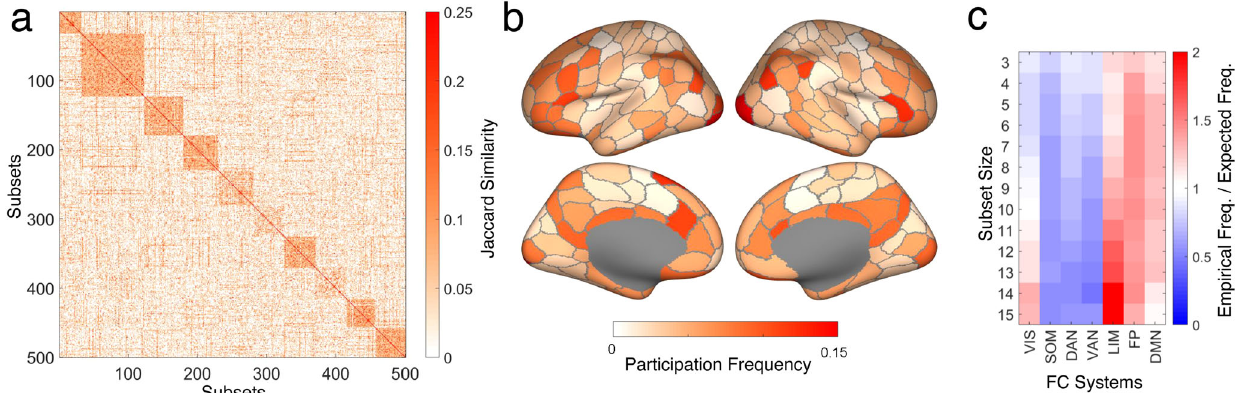
Fig. 4 Topography and functional specialization of randomly sampled synergistic subsets in the brain. Data in panels a and b was derived from a random sample of 100,000 synergistic 10-node subsets (HCP data). a Drawing random sub-samples of 500 subsets, we computed their Jaccard similarity, capturing the number of nodes in common between each subset pair. The similarity matrix was clustered using the kmeans algorithm, iterating between 2 and 30 clusters, with 10,000 repetitions. Optimal cluster quality was determined using the ‘ silhouette ’ criterion on the resulting cluster assignments. Random samples consistently yielded around 9 – 11 optimal clusters, with one example (10 clusters) shown in this panel. A Jaccard similarity of 0.25 corresponds to two subsets having 4 out of 10 nodes in common. b Frequency of individual node participation across 100,000 synergistic subsets, displayed on a surface rendering of the cerebral cortex indicating the boundaries of the 200 nodes used for constructing the FC matrix. c Each of the 200 nodes is af fi liated with one of 7 canonical functional systems 60 . Frequency of participation of individual nodes in synergistic subsets (negative O- information, subset size ranging from 3 to 15 nodes) is aggregated (averaged) for each functional system. The plot displays the ratio of empirical frequency over the expected frequency if nodes were selected by chance. A ratio > 1 or < 1 indicates that the system is over-represented or under-represented, respectively, in synergistic subsets. Sample sizes identical to those used in Fig. the ensemble contributed to the synergy, we only considered a set of nodes within that ensemble (for example, a system of three valid if it was impossible to remove any node without the synergistic elements and two independent elements will appear to O-information increasing (i.e., the contribution of each element be a synergistic system of k = 5, however, the real synergy is only was synergy-dominated). We found that, for small value of k , the in the three entangled elements). To ensure that all elements in